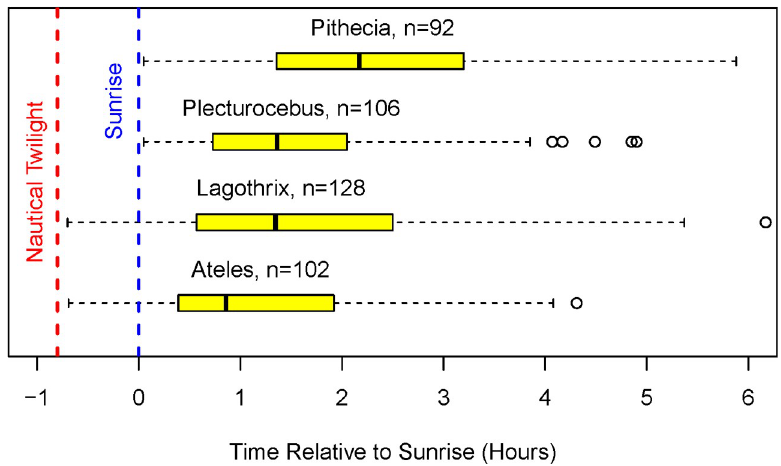
Fig 5. Time to begin first feeding bouts (hours relative to sunrise). Boxplots indicate the median and the interquartile range (IQR); whiskers indicate the extreme values unless there are data points more than 1.5 � IQR below the lower quartile or more than 1.5 � IQR above the upper quartile, in which case the whiskers stop at the first data points within those boundaries and open circles indicate more extreme points. n = number of observations.